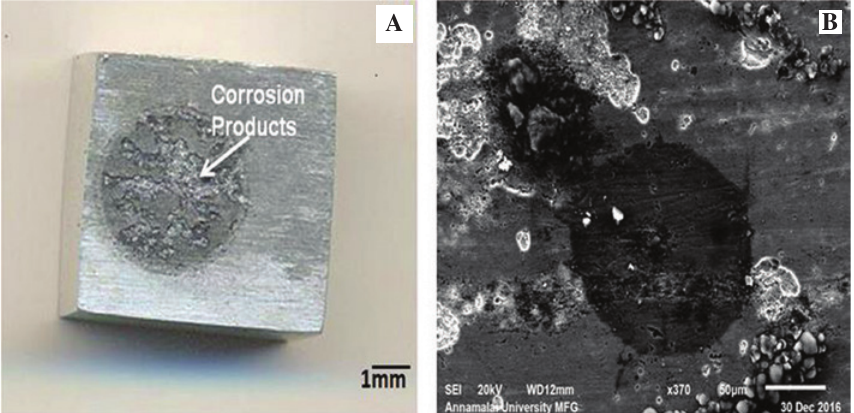
Figure 12: The corroded surface of the potentiodynamic polarisation test specimen of AA7075-T651 in a 3.5 wt.% NaCl solution. (A) Low magnification. (B) High